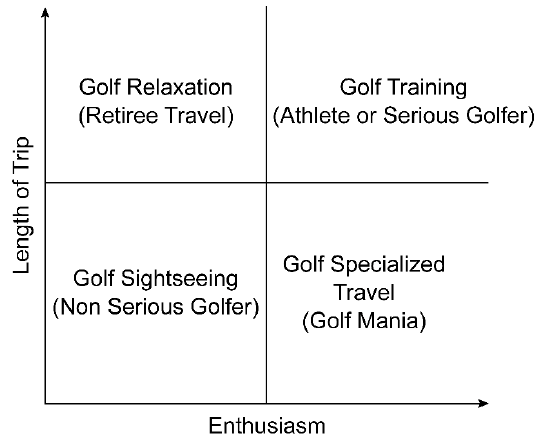
Figure 3. Golf travel